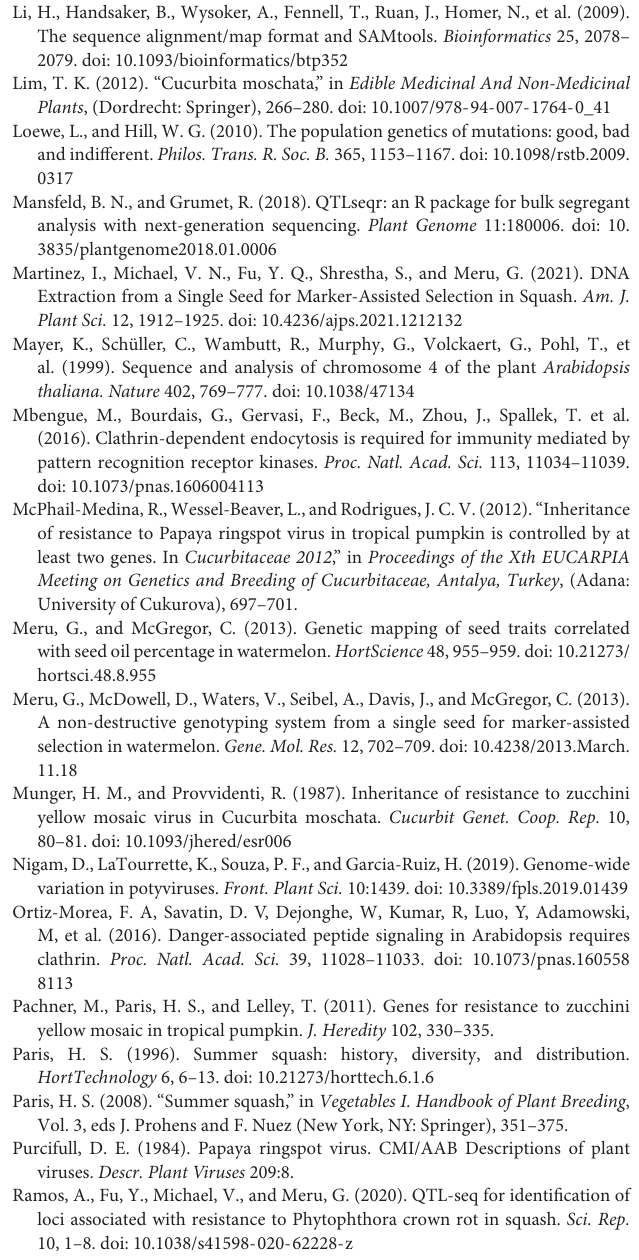
reference genome. The dotted lines (black) represent the smoothed conditional mean for SNP indexes of susceptible (S) and resistant (R) bulks. The solid blue line represents the tricube (cid:49) SNP index (R SNP index—S SNP index). The blue and red dotted lines in the (cid:49) SNP index plot are the 95 and 99% confidence intervals, respectively. Supplementary Figure 3 | Effect of Ch09_2080834 and Ch09_5023865-1 SNPs on predicted amino acid sequence on CmoCh09G004640 and CmoCh09G009540 homologs, respectively. The highlighted positions indicate the impact of SNP variants in the amino acid sequence where (A) SNP Ch09_2080834 results in a stop-gain variant resulting in a premature stop codon stop in the resistant parent and (B) SNP Ch09_5023865-1 is a stop-loss variant leading to an elongated polypeptide in the resistant